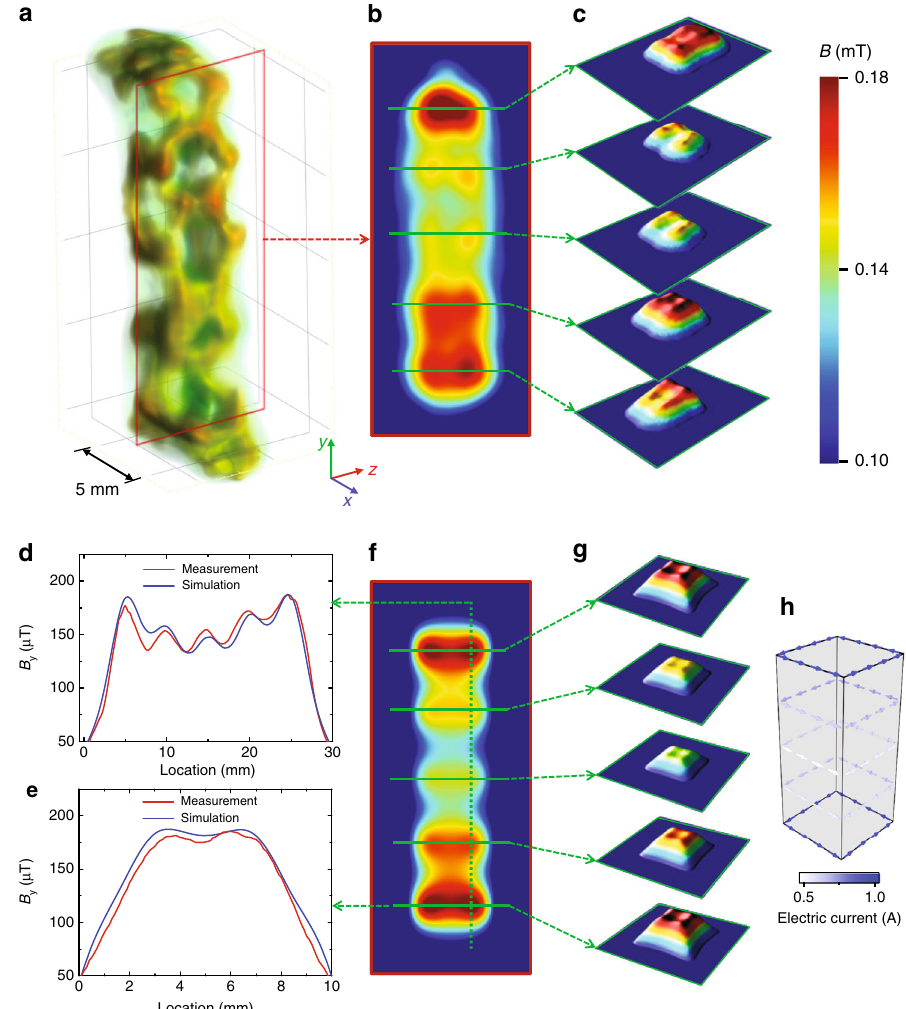
Fig. 4 Three-dimensional distribution of the y -component of the magnetic vector fi eld inside the bulk of the superconductor at 4.3 K as measured by tensorial neutron tomography. a 3D visualization of the magnetic fl ux density, where the red rectangle partially delimits the sample. The color scale used is non-linear as it is obtained by strong dynamic compression to visualize strong and weak fi elds at the same time. b Color-coded magnetic fl ux density ( y - component) in the vertical cross section ( yz -plane). c Magnetic fl ux distribution in selected horizontal planes as marked by the arrows. d , e Magnetic fl ux density distribution along the cross sections indicated in e for both measurement and simulation. f , g correspond to b , c , but show simulated magnetic fl ux distributions. h Schematic drawing of the calculated current fl ows in the effects. In the measurement presented here on a superconductor the lower limit was in the range of µT. Tomographic reconstruction technique . The new tensorial algebraic recon- struction technique (TMART) is based on the known MART algorithm 36 , but uses 3× 3 tensors instead of scalar values (see general overview in Supplementary Fig. 2). In contrast to MART, where only a single 3D data set is used as an input to create another single 3D data set as an output, the TMART algorithm is based on tensor calculations that calculate the three different components of the magnetic vector fi eld from a set of nine spin-polarized neutron imaging measurements. A neutron beam passing the volume element α i within the sample will undergo a rotation around the magnetic vector fi eld orientation unit vector ~ n i . This rotation is described by the tensor T ~ n i ; α i ð Þ (a rotation matrix). The rotation angle has to be below 180°, which is ensured by choosing a small enough volume element or limiting the magnetic fi eld. After moving through a series of volume elements α 1 , ~ n ; α ð α … , α 2 , N the corresponding tensor T final